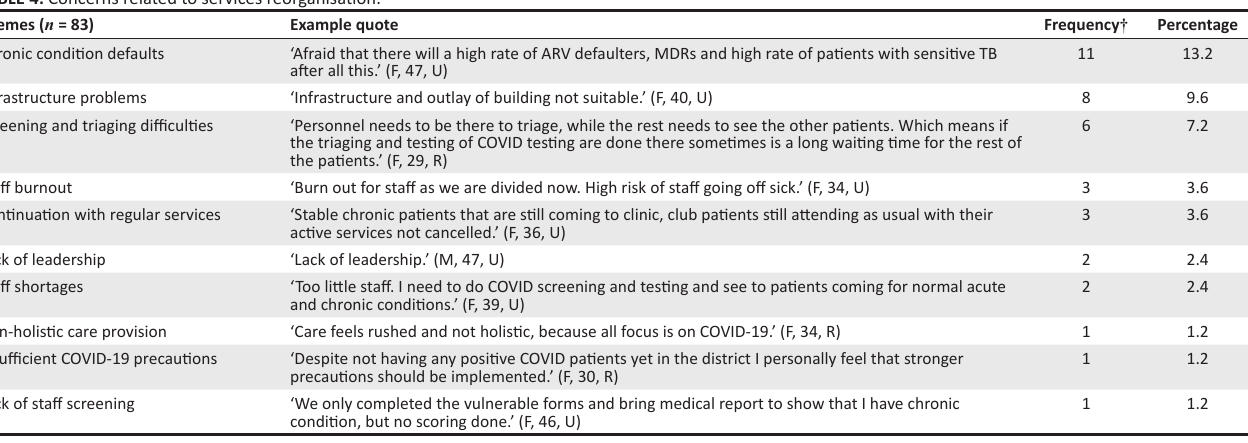
TABLE 4: Concerns related to services